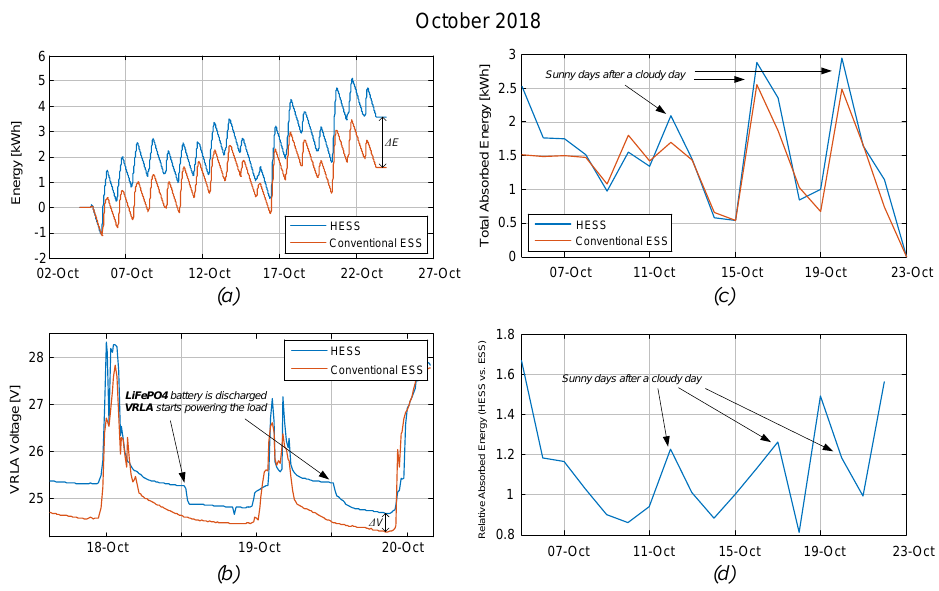
Figure 16 . Power flows within the HESS ( a ), Power flows in the HESS and in the Conventional ESS ( b ); October 2018.